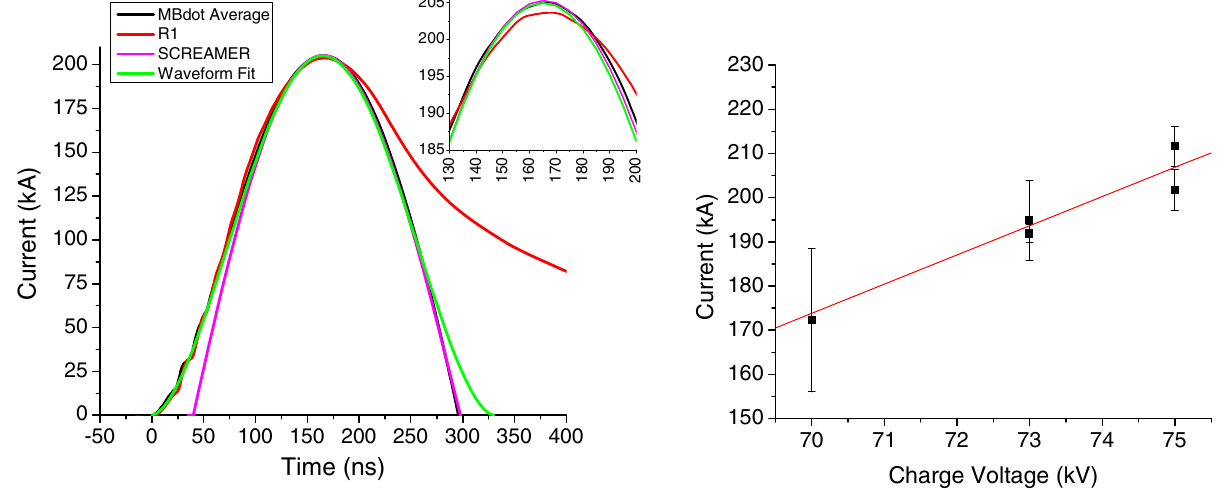
FIG. 6. (left) Comparison of machine Bdot current and return path Rogowski coil currents to SCREAMER output and a waveform fit [Eq. (4)] for a cylindrical wire array load, and (right) scaling of load current with charge voltage for cylindrical